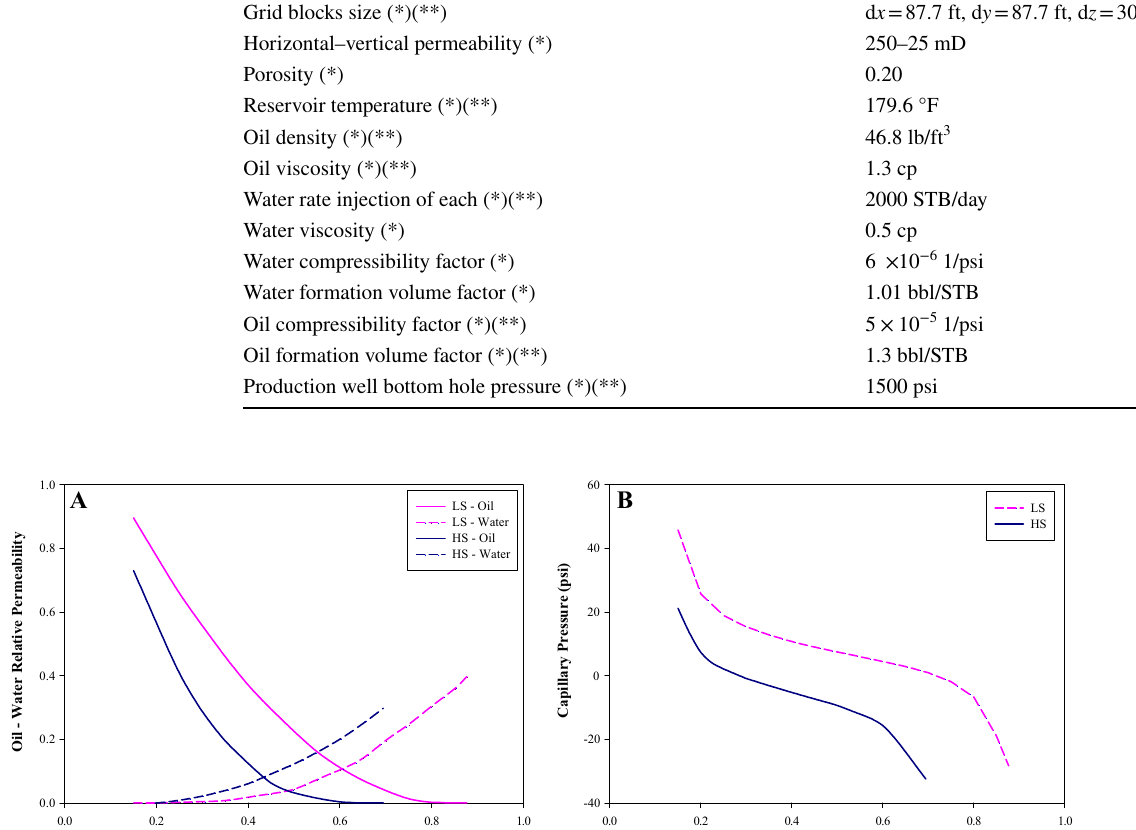
Table 1 Basic reservoir properties of base case (*) for validation and general model (**)